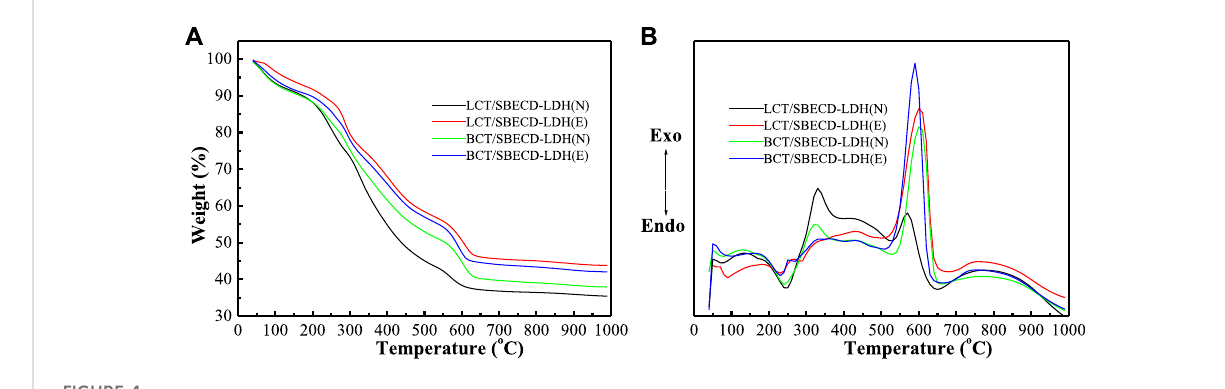
FIGURE 4 TGA (A) and DTA (B) curves of BCT (LCT)/SBECD-LDH samples.